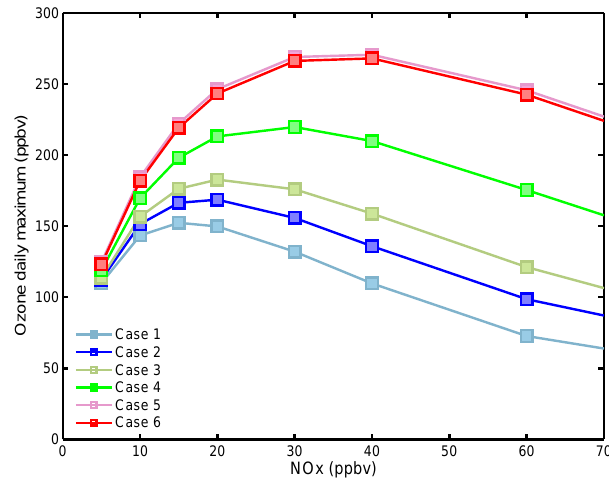
Fig. 7. NCAR-MM model simulation results. Six cases are based on measurements of VOCs on each day of 7–12 August, with all other parameters set to be the same. The square markers are selected cases for NO x =5, 10, 15, 20, 30, 40 and